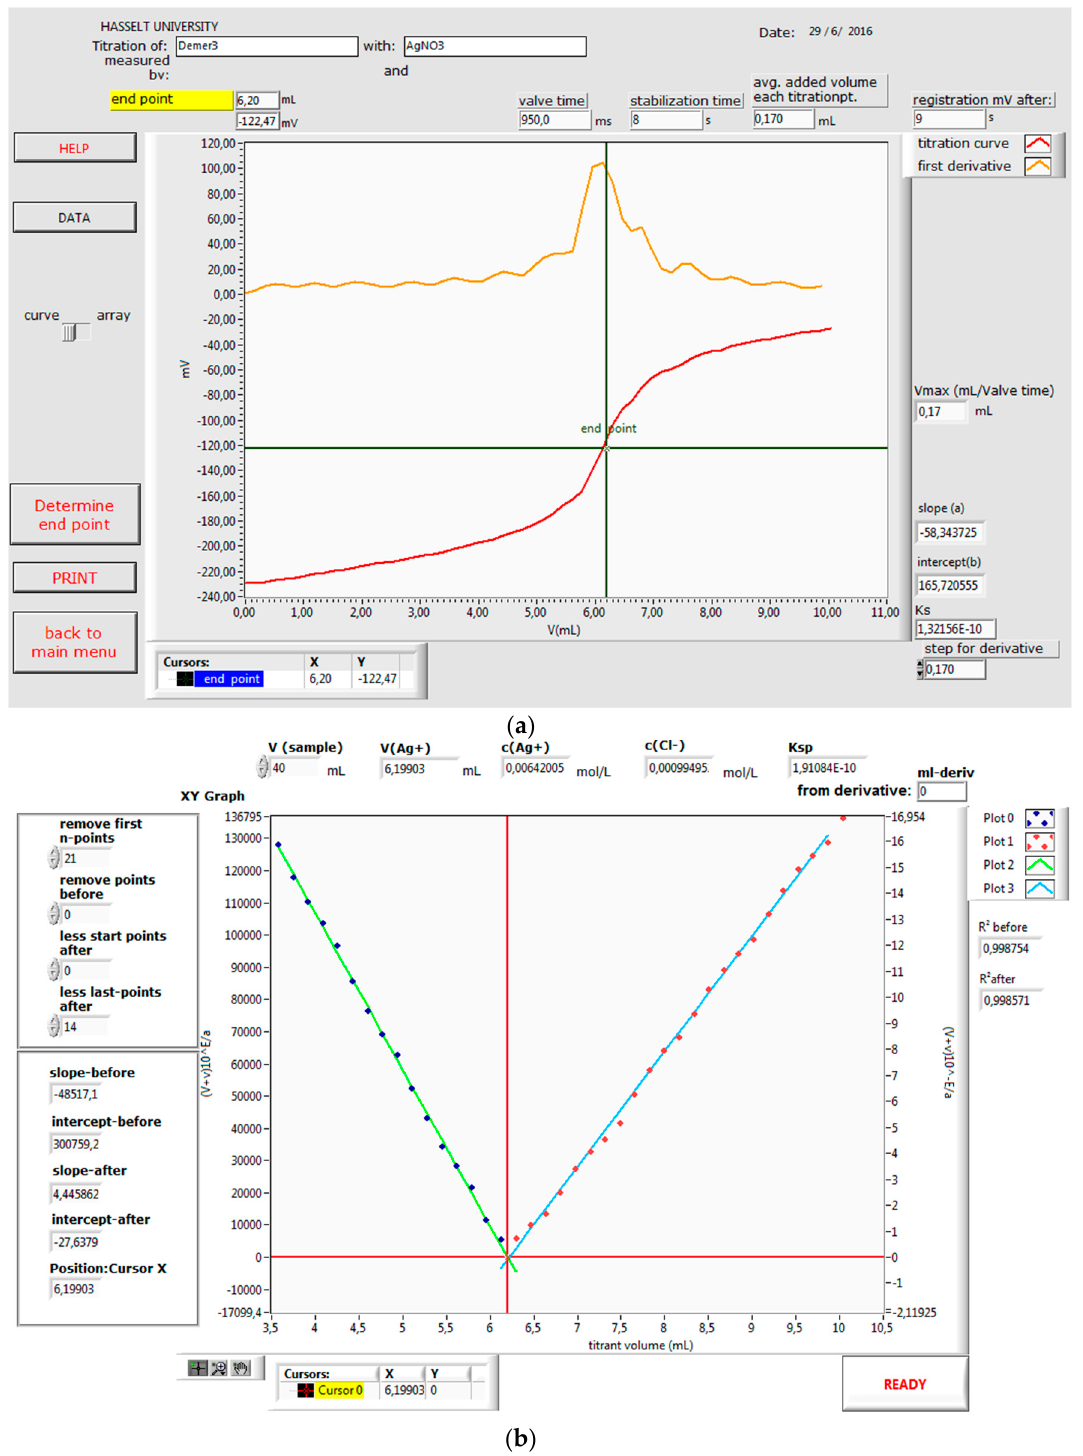
Figure 6. ( a ) Precipitation titration curve (titration 2; Table 2) of a sample of fresh river water at 298.29 K, E (mV) versus V (mL) standard AgNO 3 solution (red); plot of numerical first derivatives (built-in LabVIEW VI function) with a maximum at the endpoint (orange); ( b ) Gran plot with an intersection of two linear regression lines at the end point of the titration. In the Gran plot, the two intersecting linear regression lines before and beyond the EP are derived as follows [15]